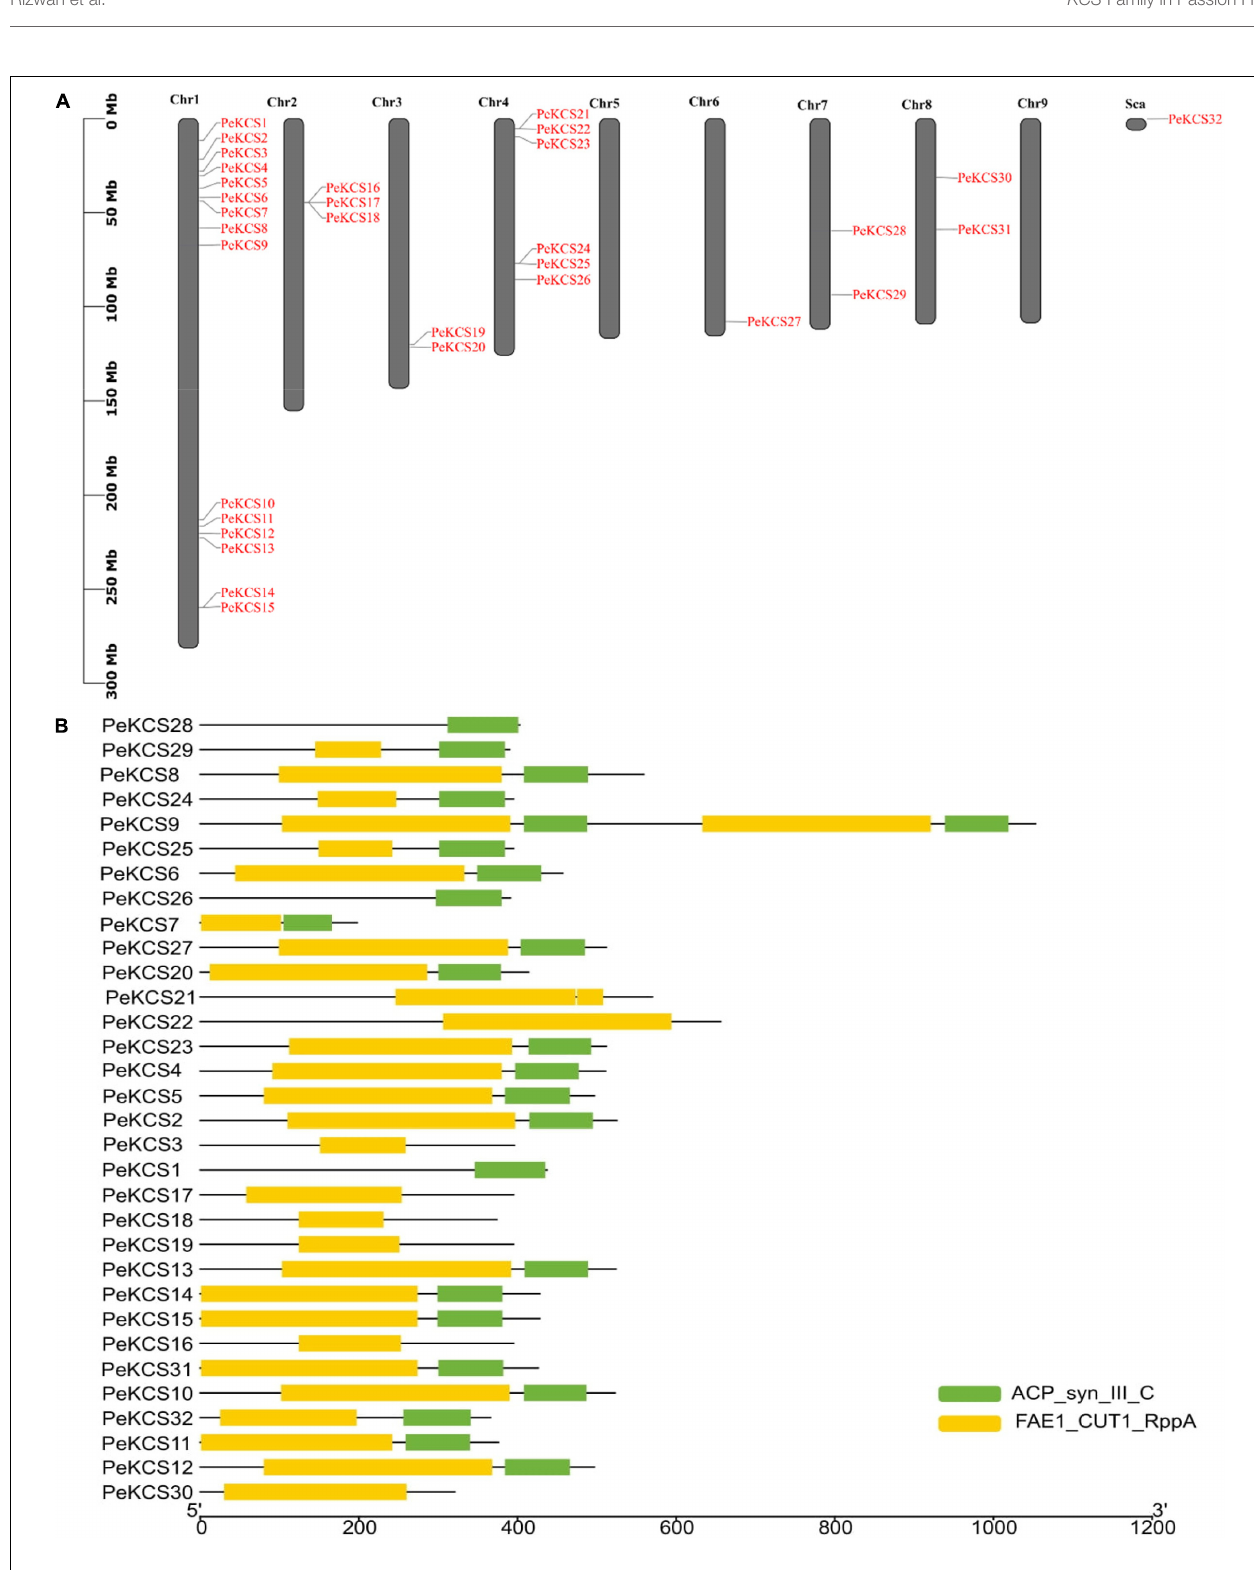
FIGURE 1 | Chromosome location and conserved domains of PeKCS in passion fruit. (A) Chromosomal location of PeKCS genes, the scale represents the 300 MB chromosomal distance and the PeKCS genes are represented in red color. (B) The two conserved domains of PeKCS genes in passion fruit named as FAE1_CUT1_RppA: FAE1 (PF08392); ACP_syn_III_C (PF08541) (readers are referred to the Web version of this article for the understanding of the references to color in this figure legend). Sca-scaffold chromosome.